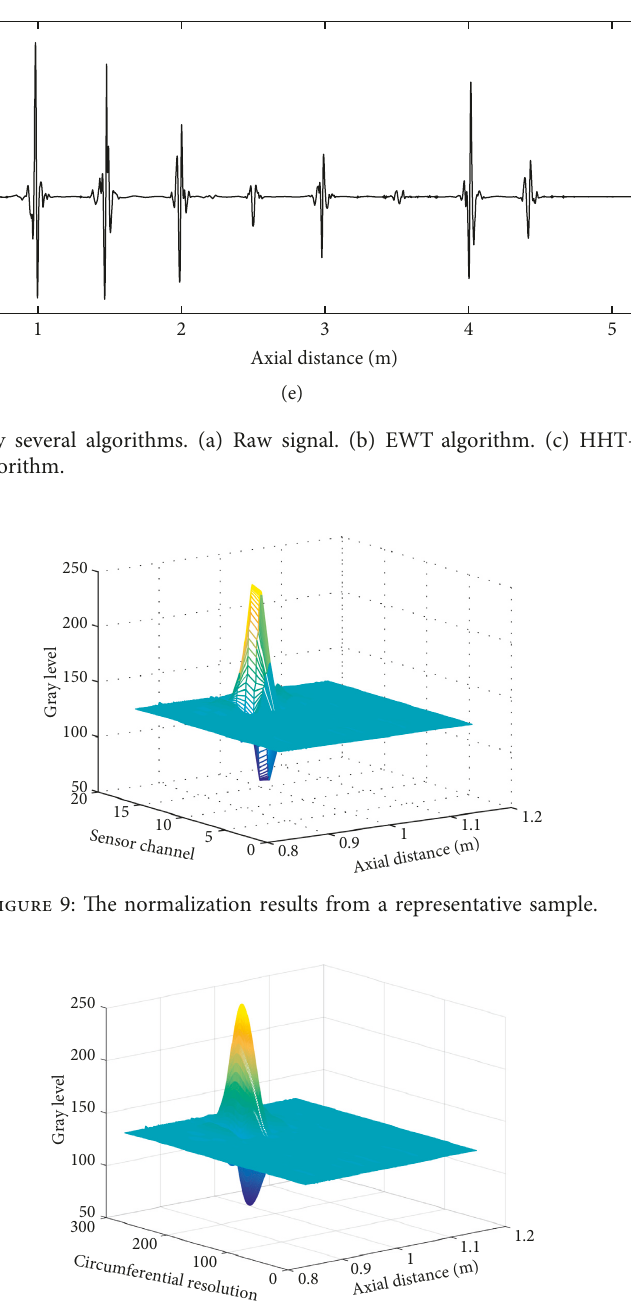
Figure 10: Data after improving the circumferential resolution.